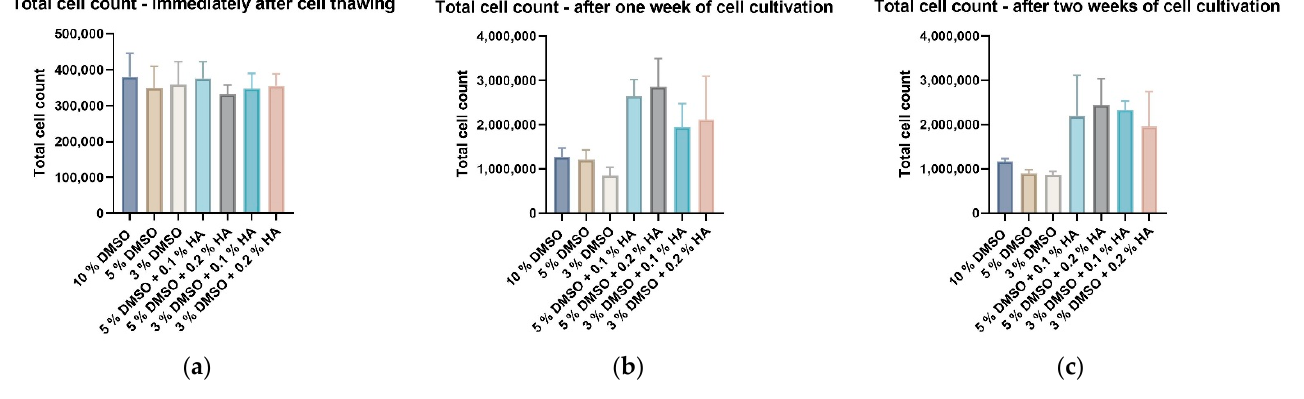
Figure 2. Total DPSC count measured using Z2-Counter (Beckman Coulter): ( a ) immediately after thawing; ( b ) after one week of cell cultivation; ( c ) after two weeks of cell cultivation. Data are presented as a mean and SD plotted as error bars. The statistical analysis was performed between control and experimental groups using Friedman’s test followed by Dunn’s multiple comparison test.